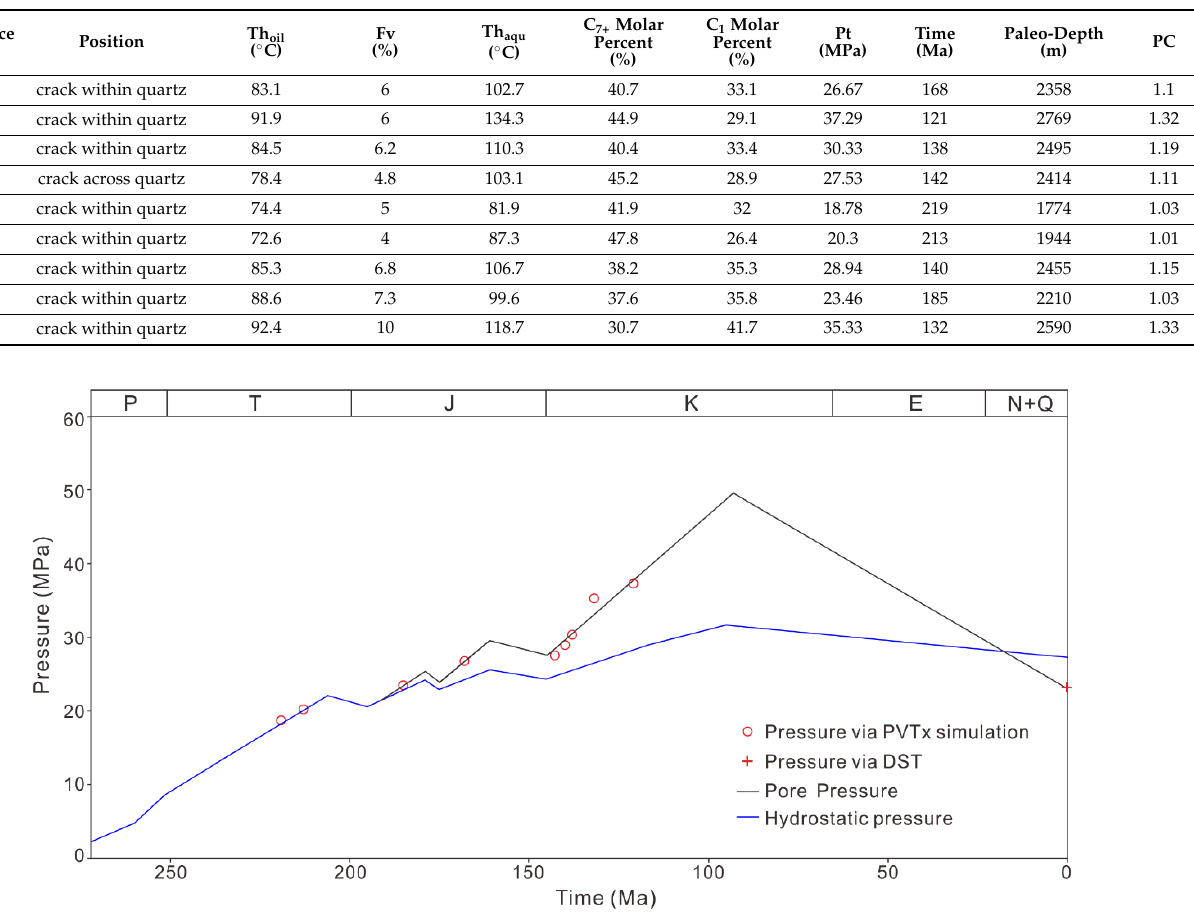
Figure 9. Pressure evolution of the well J77 via inclusion thermodynamic simulation and 1D basin modeling.